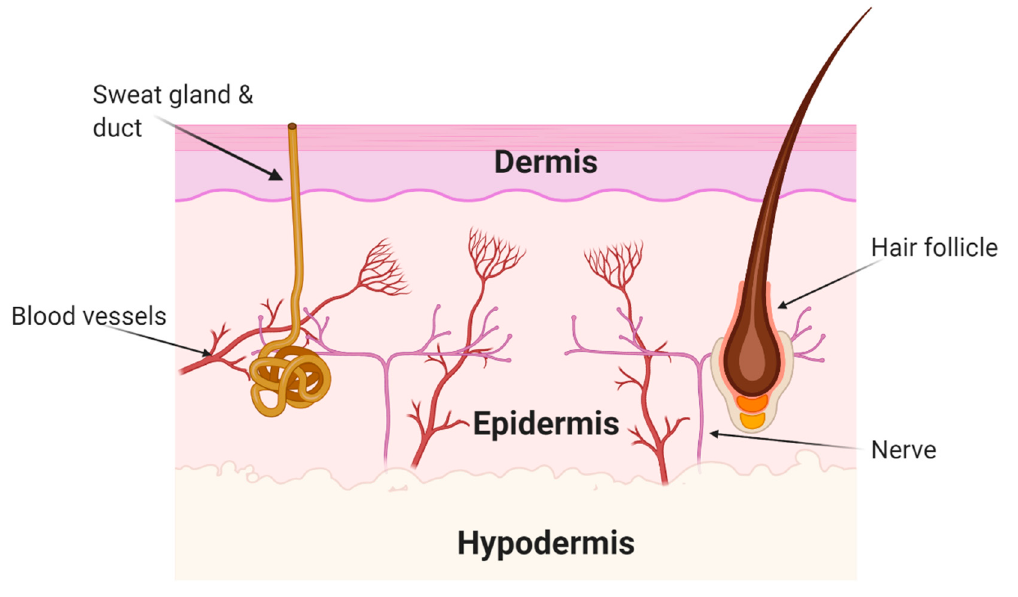
Figure 3. Illustrative representation of the anatomy of human skin.